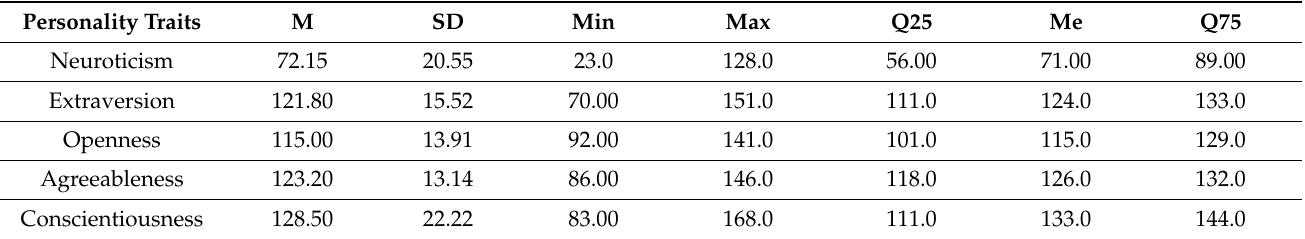
Table 3. Level of personality traits according to the five-factor model among athletes training team sports (N = 213) (descriptive statistics).